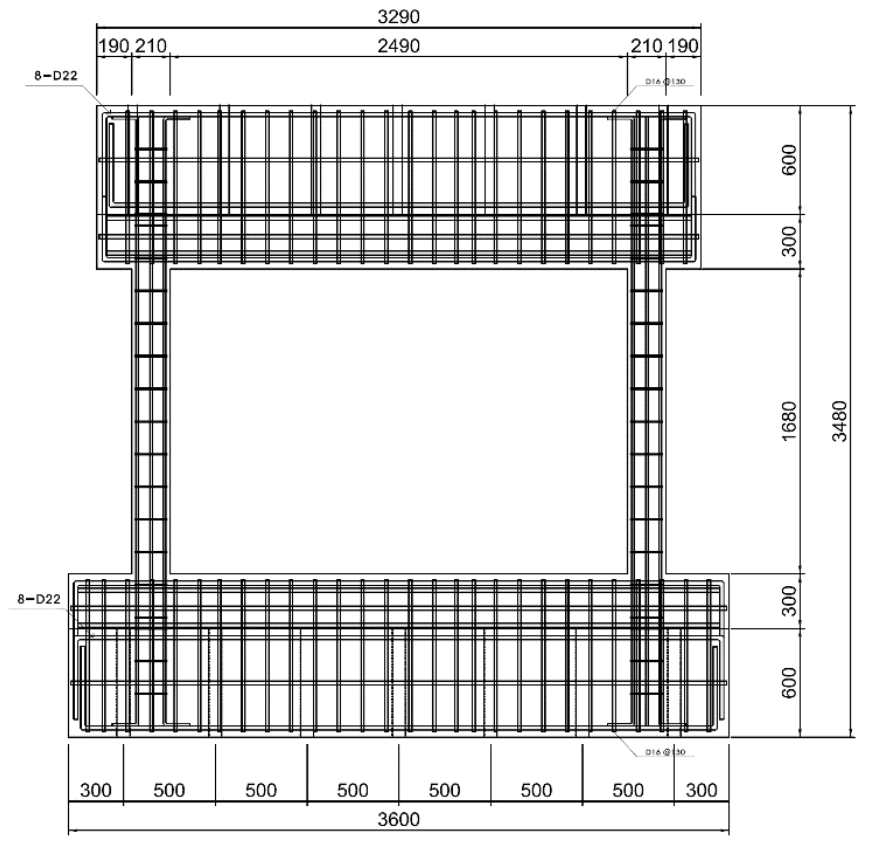
Figure 6. Reinforcement placing of the test specimen. Table 2. Characteristic value of concrete and material properties of steel (unit: